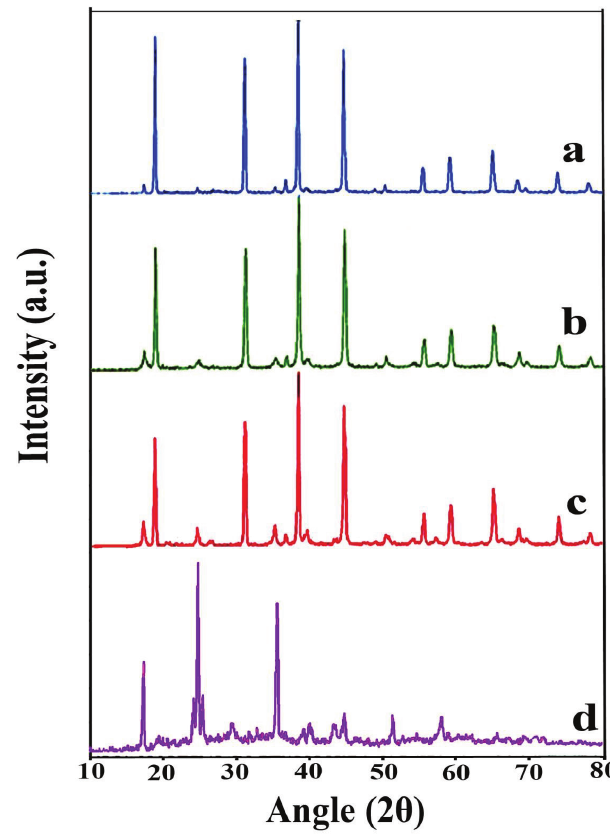
Fig. 6. XRD patterns of the prepared magnetite nanoparticles by two methods; solvothermal in different times: 12 h (a), 24 h (b), 36 h (c); and hydrothermal for 12 h (d) at 200˚C.